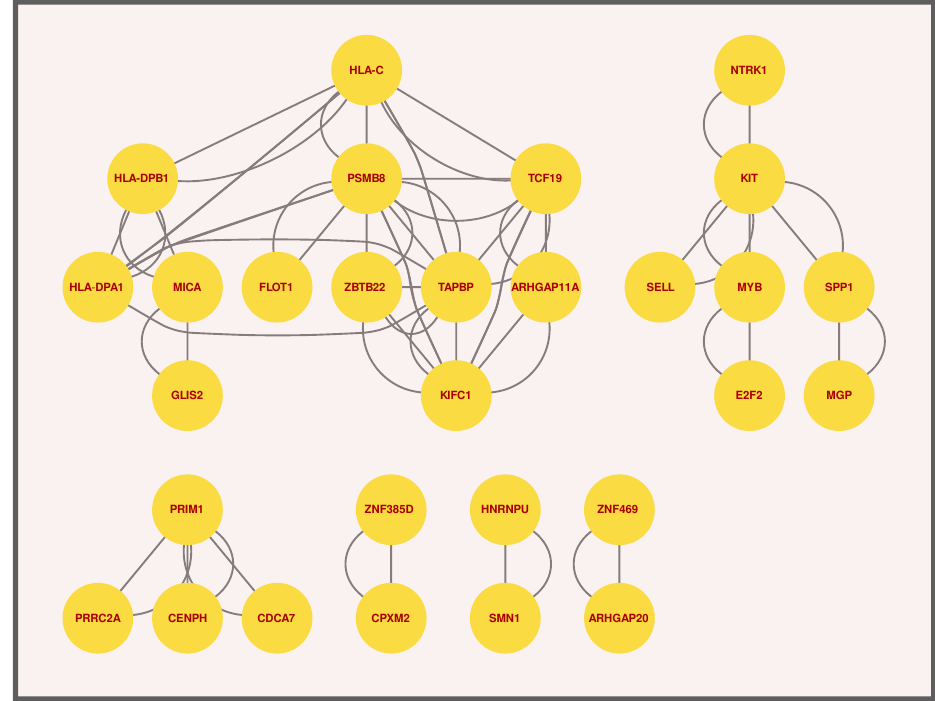
Figure 6. The figure illustrate the Protein–Protein Interactions between T2D and